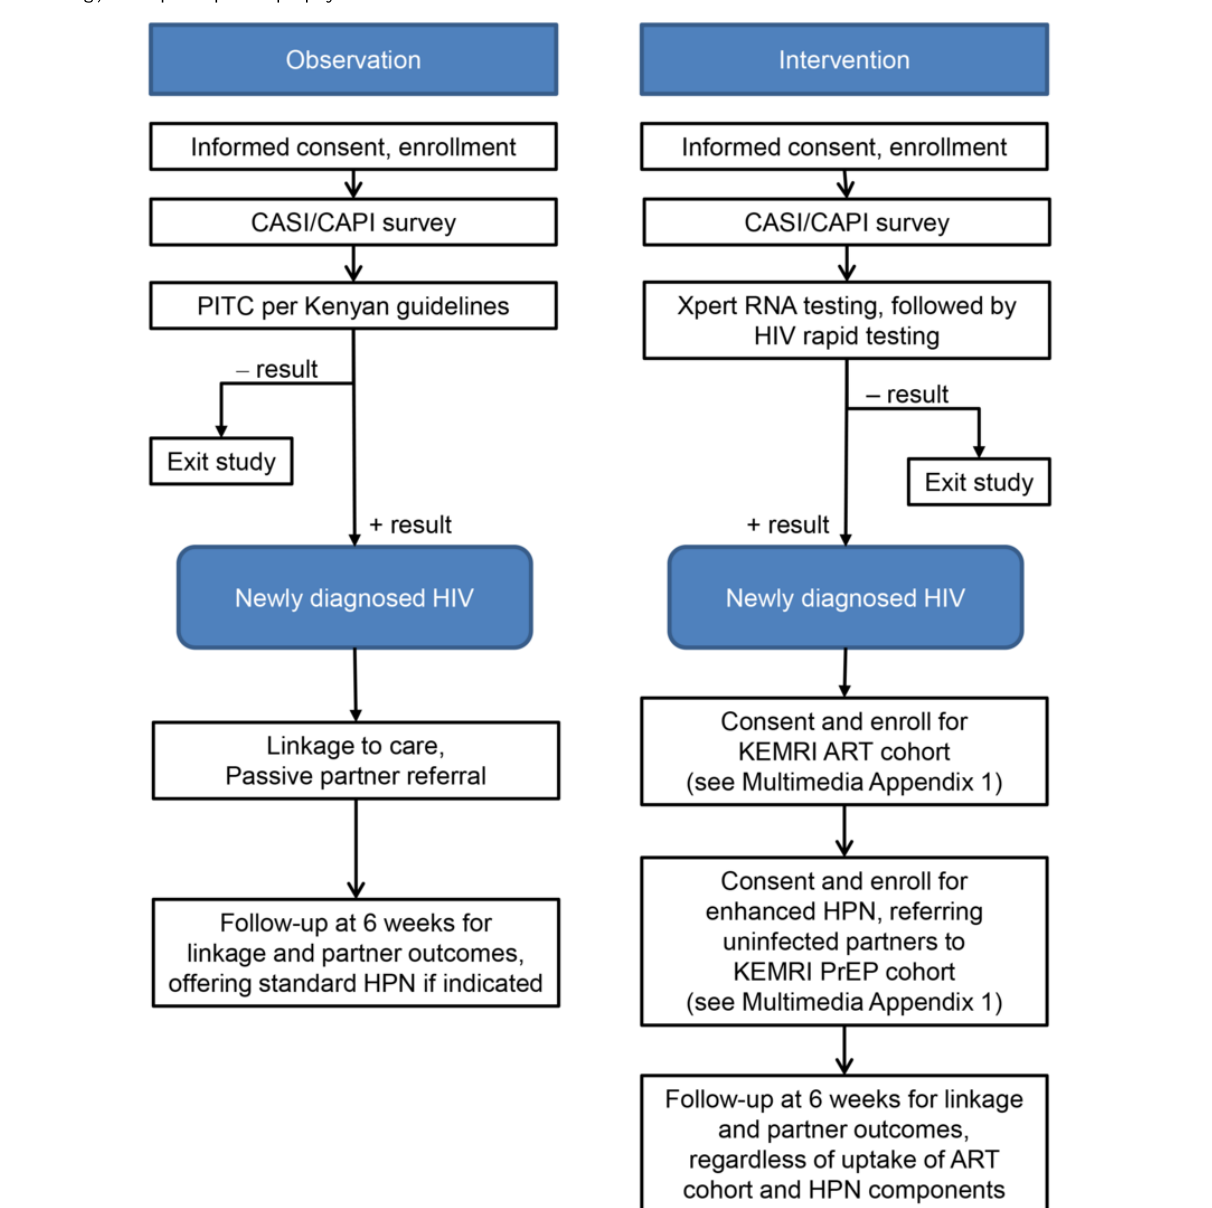
Figure 3. Flow diagram of observation and intervention periods. ART: antiretroviral therapy; CAPI: computer-assisted personal interview; CASI: computer-assisted self-interview; HPN: HIV partner notification services; KEMRI: Kenya Medical Research Institute; PITC: provider-initiated testing and counseling; PrEP: pre-exposure